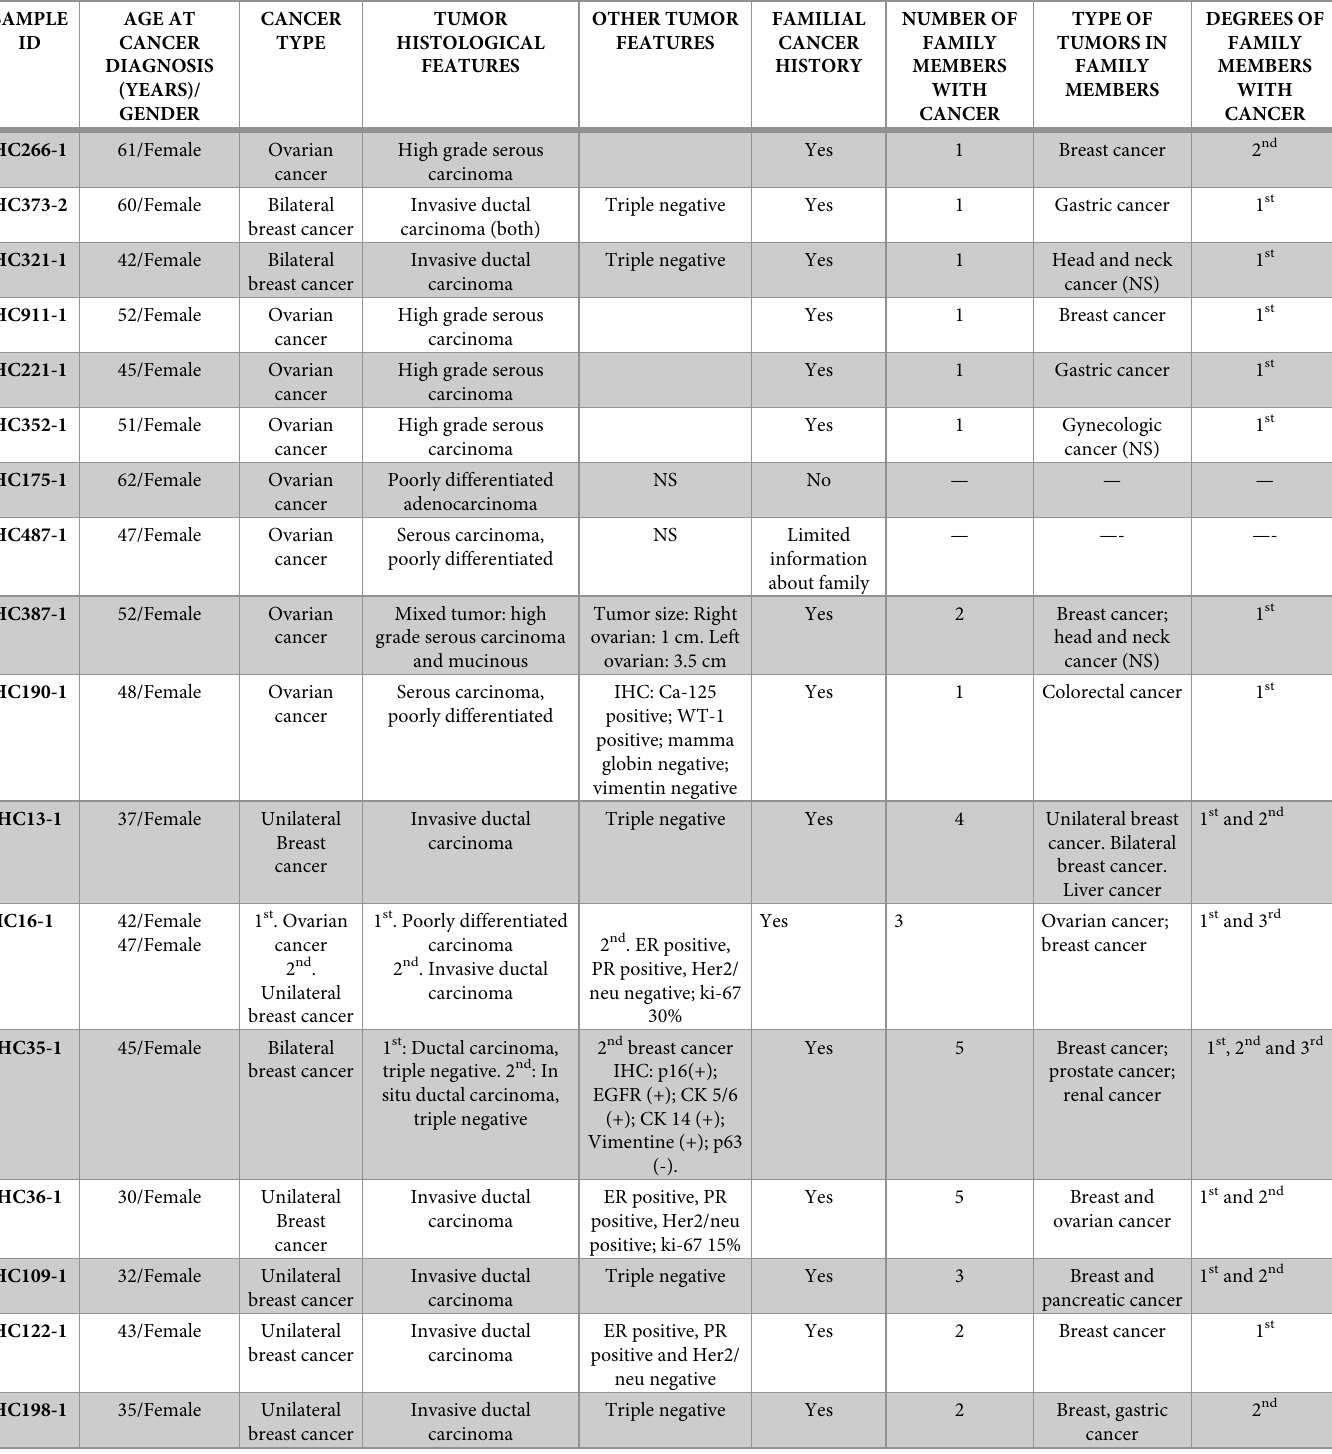
Table 1. Clinical and familial features of cancer patients carriers of 9–12 del BRCA1